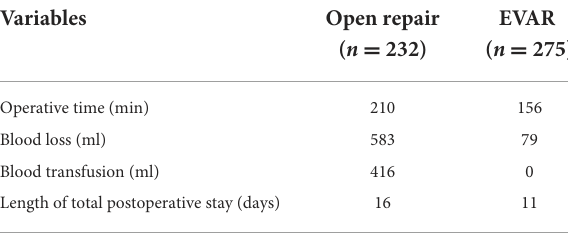
TABLE 4 Perioperative outcomes.